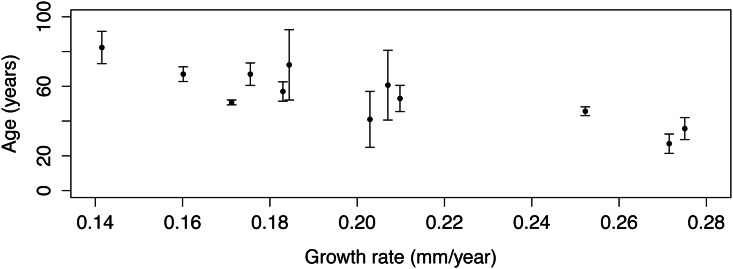
Relationship between age and annual basal diameter growth rate of Corallium rubrum from 12 colonies collected off Portugal (70-90m depth).Error bars represent standard deviation.